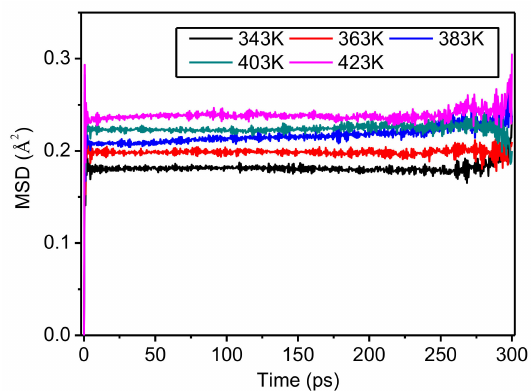
Figure 4. Mean square displacement (MSD) of crystalline regions of meta-aramid fibers at different